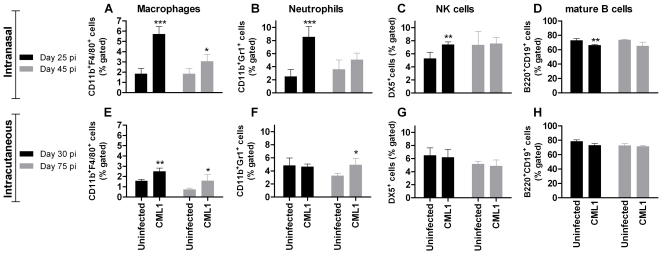
Identification of changes in immune cell populations from spleen of nu/nu mice exposed to CML1.Mice (n = 4 per group) were challenged i.n. (A–D) or i.c. (E–H) with PBS (uninfected) or with CML1 at a dose of 2.0×106 PFU. At 25 and 45 dpi for the i.n. model or at 30 and 75 dpi for the i.c. model, spleen were harvested and CD11b+F4/80+ macrophages, CD11b+Gr1+ neutrophils, DX5+ NK cells and B220+CD19+ mature B cells were identified by FACS. Results are presented as percent gated cells. Bars represent mean±SD, standard deviation (n = 4). ***p<0.001; **p<0.01 and *p<0.05: CML1 differs significantly from uninfected group as determined by unpaired t test; representative of two independent experiments.